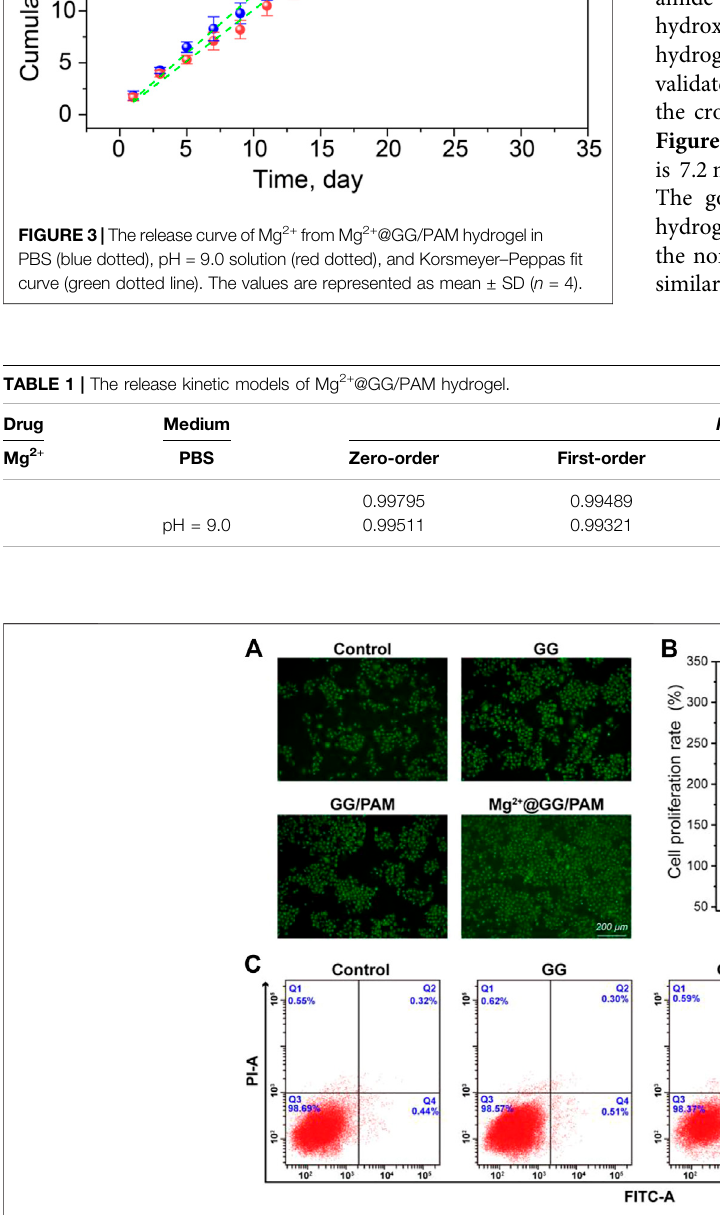
FIGURE 4 | Cytotoxicity of Mg 2+ @GG/PAM hydrogel in vitro . (A) The AO-EB staining of fi broblast cells cultured with control, GG, GG/PAM, and Mg 2+ @GG/PAM hydrogel surface for 72 h. (B) The cell viability of fi broblastcells using ImageJ software for 1, 3, and 7 days (means ± SD, n (cid:1) 4). (C) Apoptosis analysis of fi broblast cells by fl ow cytometer. * p < 0.05, ** p < 0.01 vs control.